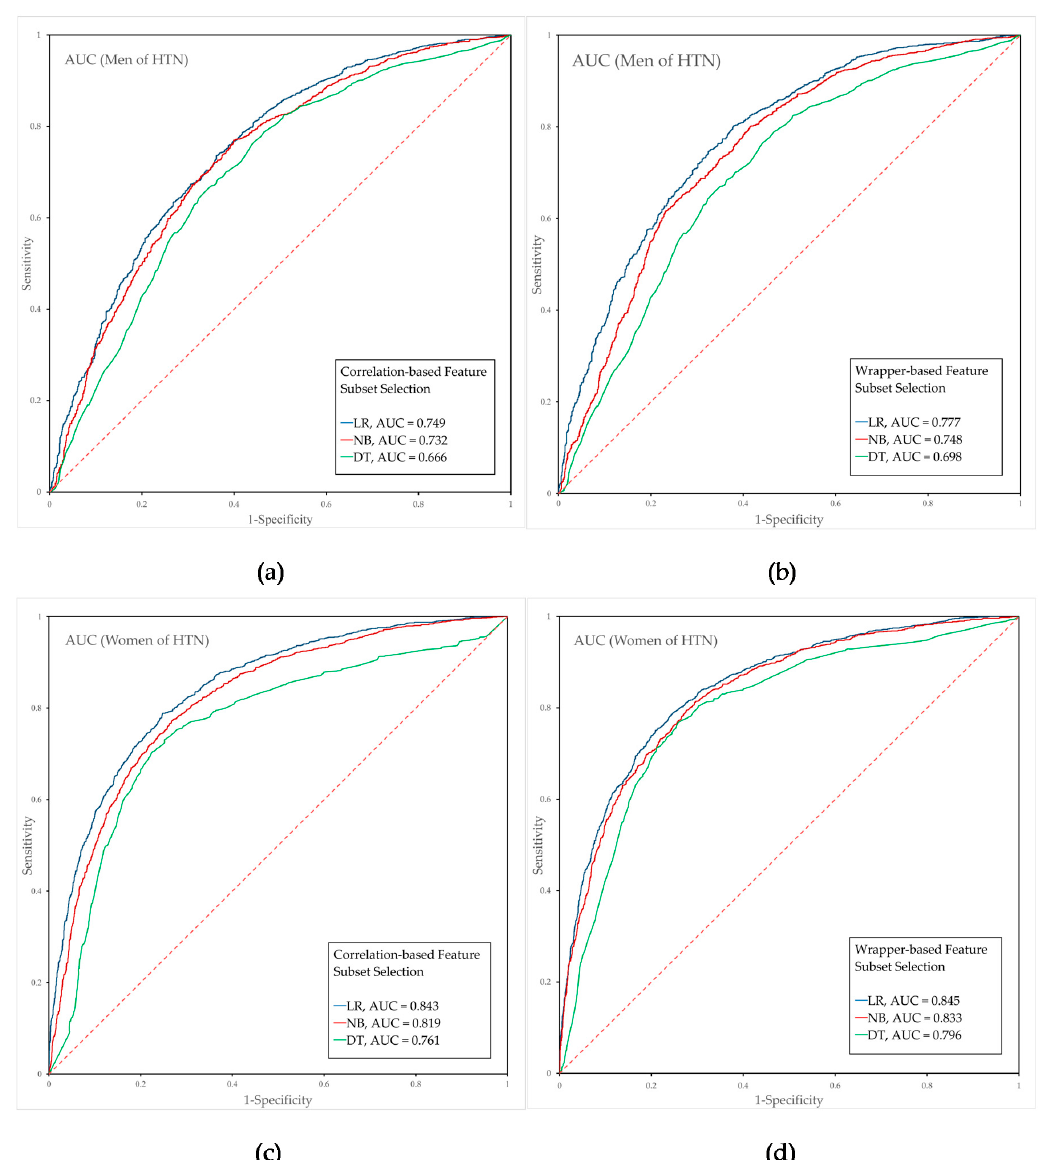
Figure 3. Predictive power of each hypertension prediction model for men and women. Each graph presents the results for the LR, NB, and DT algorithms. ( a , b ) present the results for men, and ( c , d ) present the results for women. ( a , c ) show the results obtained with CFS, and ( b , d ) show the results obtained with WFS. Abbreviations: LR, logistic regression; NB, naïve Bayes; DT, decision tree; AUC, area under the receiver operating characteristic curve; HTN, hypertension; CFS, correlation-based feature selection; WFS, wrapper-based feature selection.